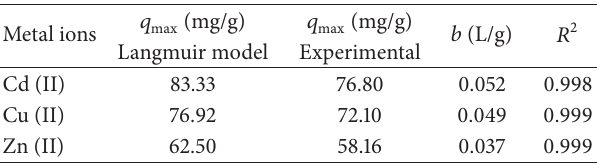
Figure 4: Adsorption isotherm for the Cd (II), Cu (II), and Zn (II) onto Aminated Desmostachya bipinnata (ADBP). Table 1: Langmuir adsorption model parameters and experimental 𝑞 max